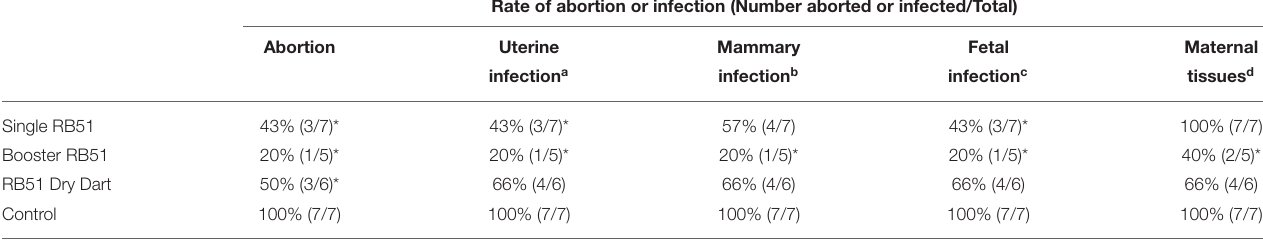
TABLE 1 | Efficacy of Brucella abortus strain RB51 vaccination strategies in protecting against experimental challenge at midgestation with 10 7 colony-forming units of B. abortus strain 2,308. Rate of abortion or infection (Number aborted or infected/Total) Abortion Uterine Mammary Fetal Maternal